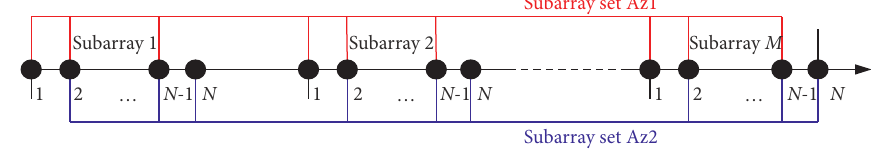
Figure 2: Subarray partition for DOA